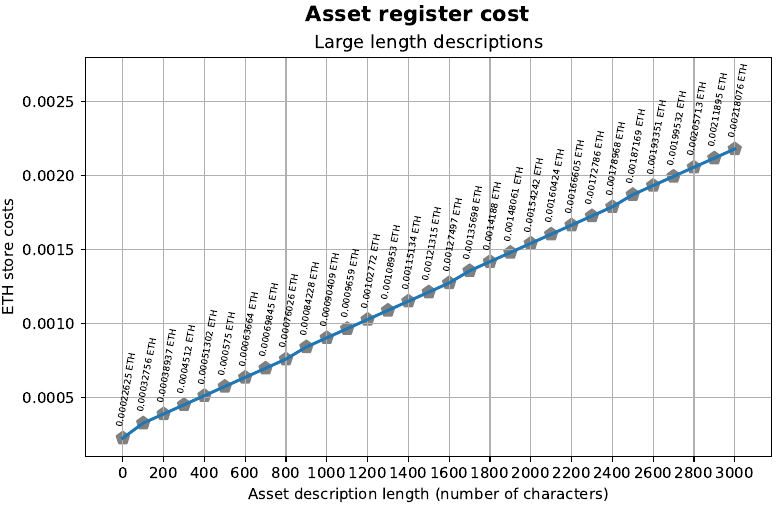
Figure 14. Ethereum cost to save a long-length string description for the assets in the blockchain. In total, 100 characters cost ETH 0.00032756, and 3000 characters cost ETH